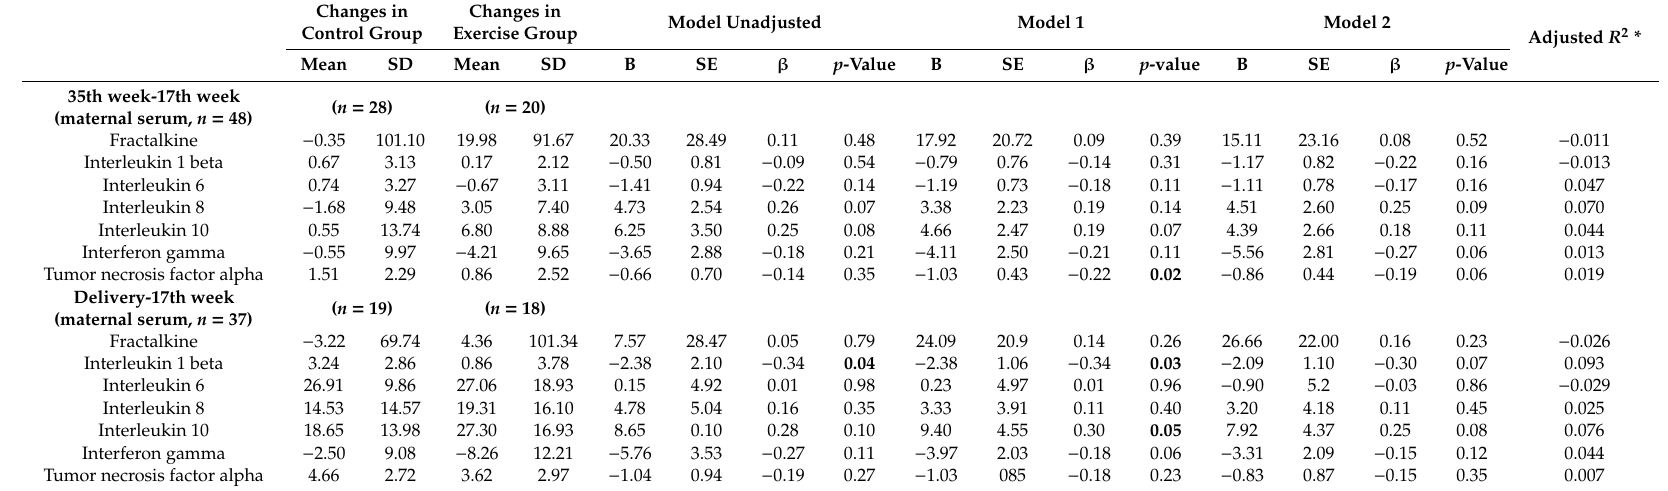
Table 3. Per-protocol analyses showing the e ff ect of the concurrent exercise-training program on maternal serum cytokines ( n =